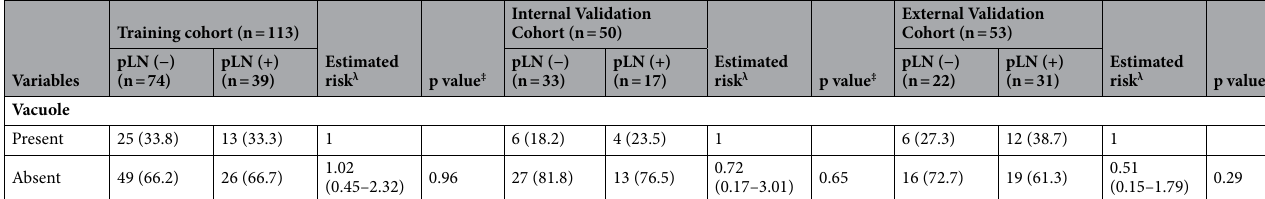
Table 1. Clinical arameters of patients on training, internal and external validation cohort. pLN (−) pathologically lymph node negative, pLN (+) pathologically lymph node positive, CEA carcinoembryonic antigen, GGO ground glass opacity, RUL right upper lobe, RML right middle lobe, RLL right lower lobe, LUL left upper lobe, LLL left lower lobe. λ Odd ratio with univariate test; ‡ Chi-square test or Mann–Whitney test; *